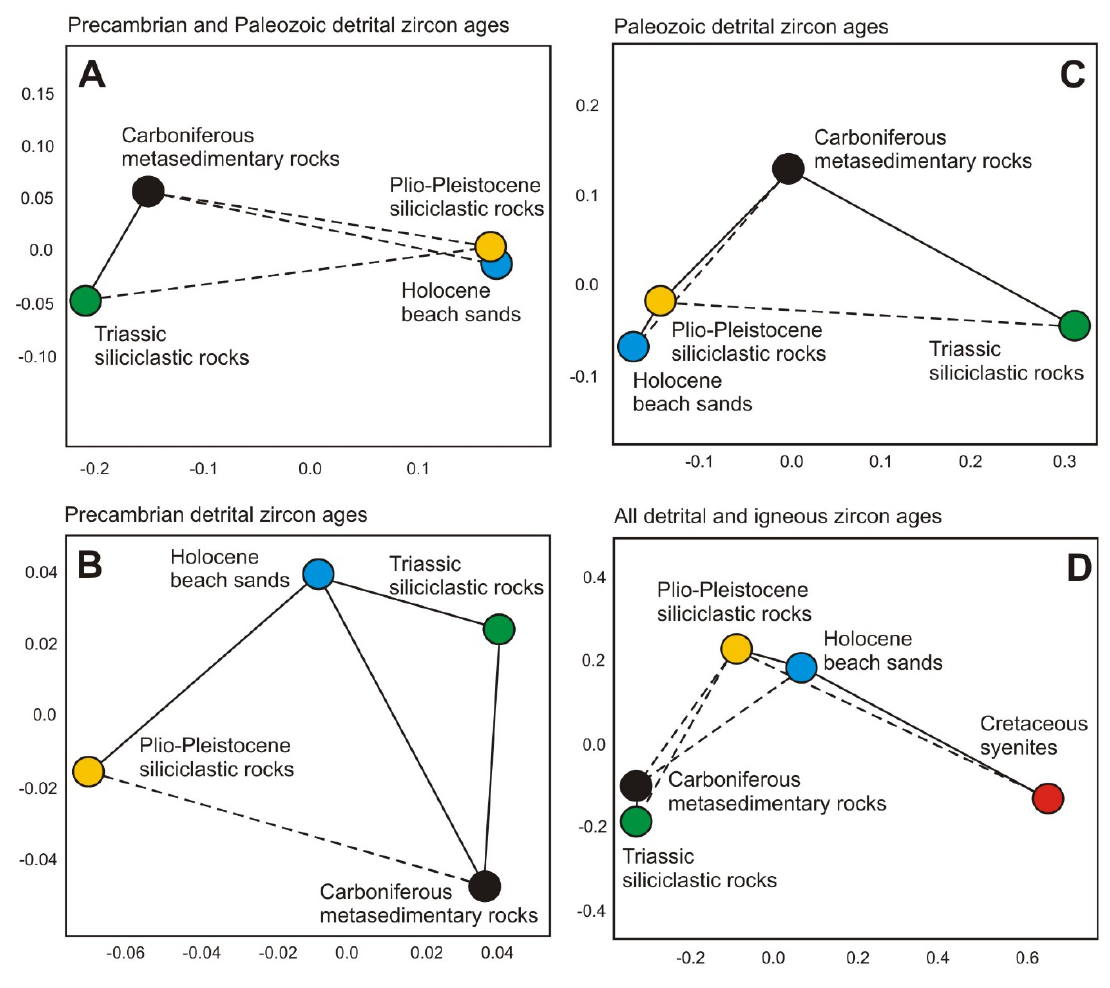
Figure 5. Multidimensional scaling (MDS) diagrams with U–Pb detrital zircon ages of the Carboniferous (Mira Formation, South Portuguese Zone), Triassic (Silves Group, Alentejo Basin), and Pliocene-Pleistocene (Alvalade Basin) siliciclastic rocks, as well as Holocene beach sands from the Sines region. ( A ) Precambrian and Paleozoic detrital zircon ages. ( B ) Precambrian detrital zircon ages. ( C ) Paleozoic detrital zircon ages. ( D ) All detrital zircon ages together with the magmatic zircon ages from the Sines pluton (U–Pb data compiled from [16,28,29,34,39,40]).